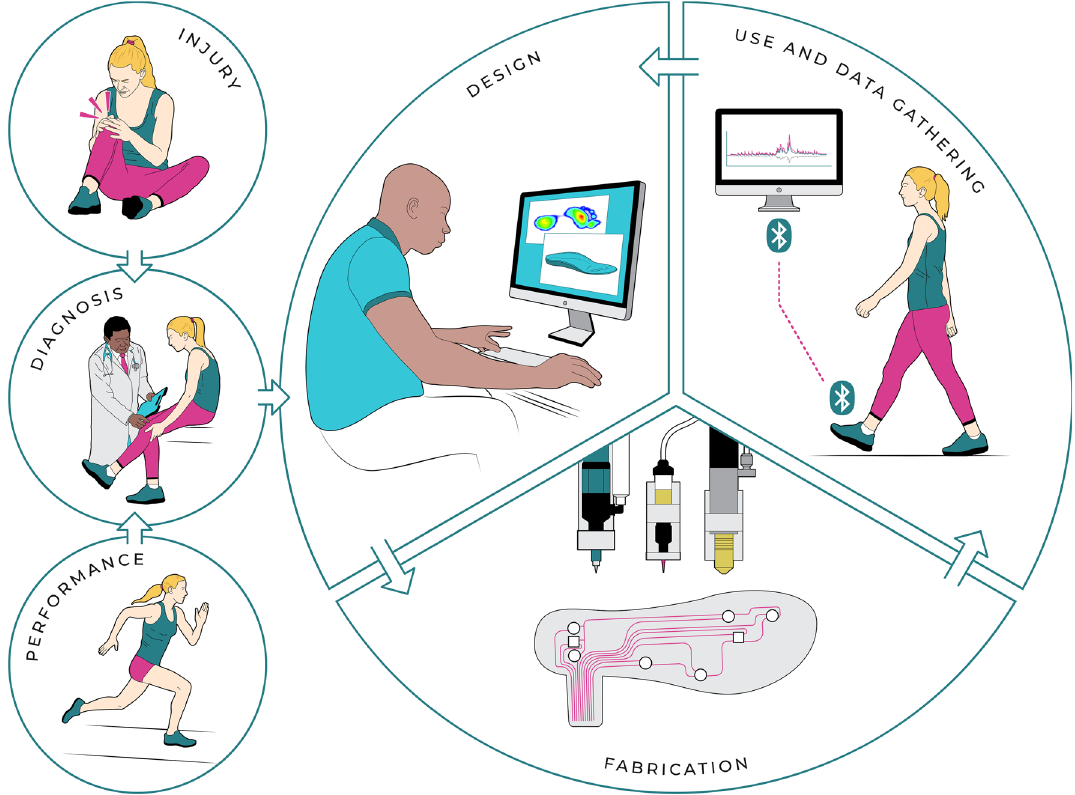
Figure 1. Proposed analysis and fabrication cycle of customized insoles with embedded sensors. In the envisioned workflow, a trained healthcare worker can 3D print the insole based on the initial medical diagnosis and later print adapted versions of it considering the gait data captured during physical activities. Illustration provided by Estevam Quintino (CC BY